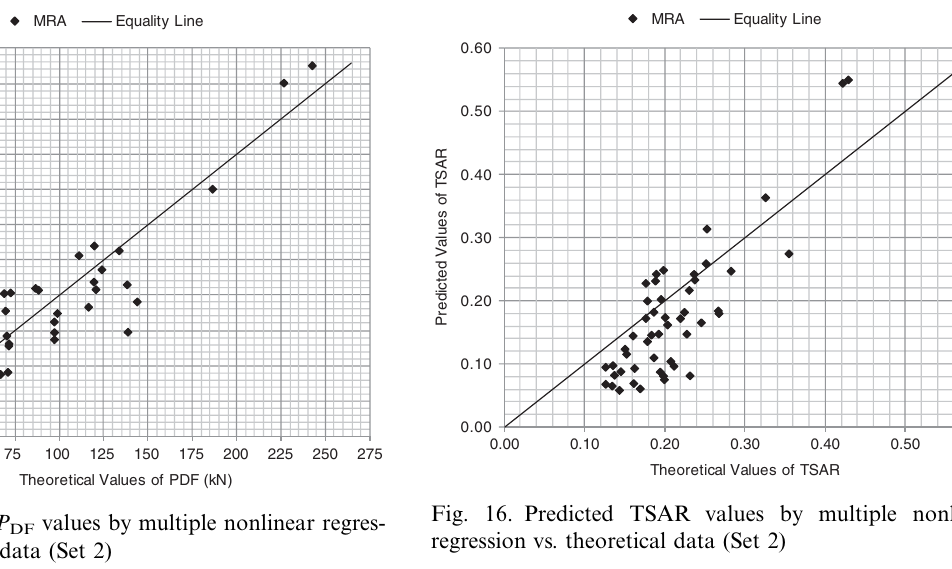
Fig. 13. Recalled TSAR values by multiple nonlinear regression vs. theoretical data (Set 1)